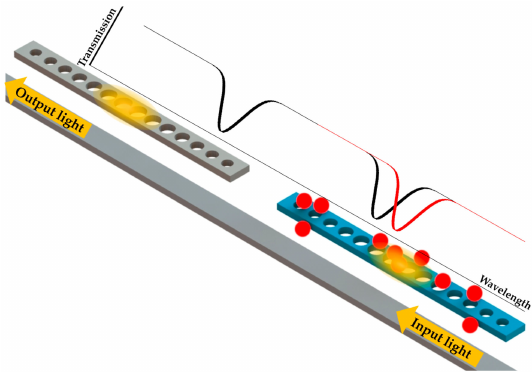
Figure 10. Schematic of nanoparticle